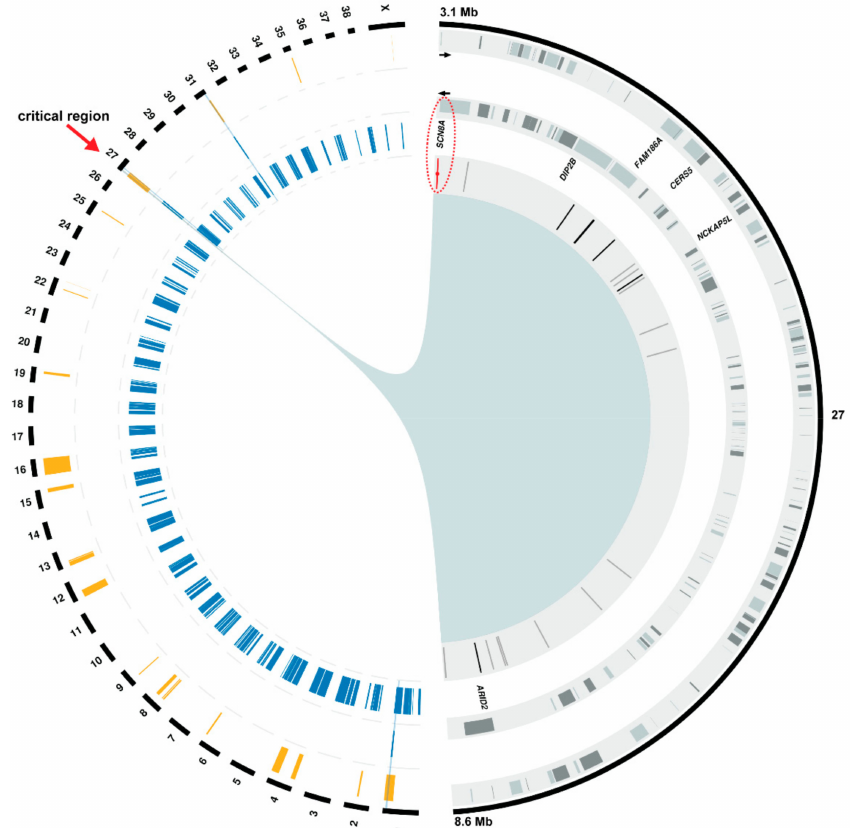
Figure 3. Positional cloning of the spinocerebellar ataxia-associated variant. The canine chromosomes are depicted in the left half of the circle as black bars. Below, the 3 circular tracks from outside to inside indicate: (i) 23 genome segments from linkage analysis in orange, (ii) four homozygous blocks shared in a ff ected dogs in blue, (iii) homozygous blocks found in una ff ected dogs in blue. The initial four segments overlapping in cases are indicated by a blue background. Only a single interval on chromosome 27 showed both linkage and homozygosity in a ff ected dogs and no homozygosity in una ff ected dogs. Therefore, it was considered the critical region for spinocerebellar ataxia (red arrow). The right half of the circle displays a close-up view of this region (chr27:3,154,712-8,679,881) with 3 circular tracks below showing from outside to inside: (i, ii) gene content showing the 165 genes (grey boxes) annotated on both, the positive (outer circle) and negative (inner circle) strand, (iii) location of private intergenic (grey), intronic (black), and exonic (red) SNVs depicted as vertical lines. For clarity, only the names of six genes, in which an intronic or exonic SNV was found, are shown. Note the red ellipse highlighting the single protein-changing SNV in the SCN8A